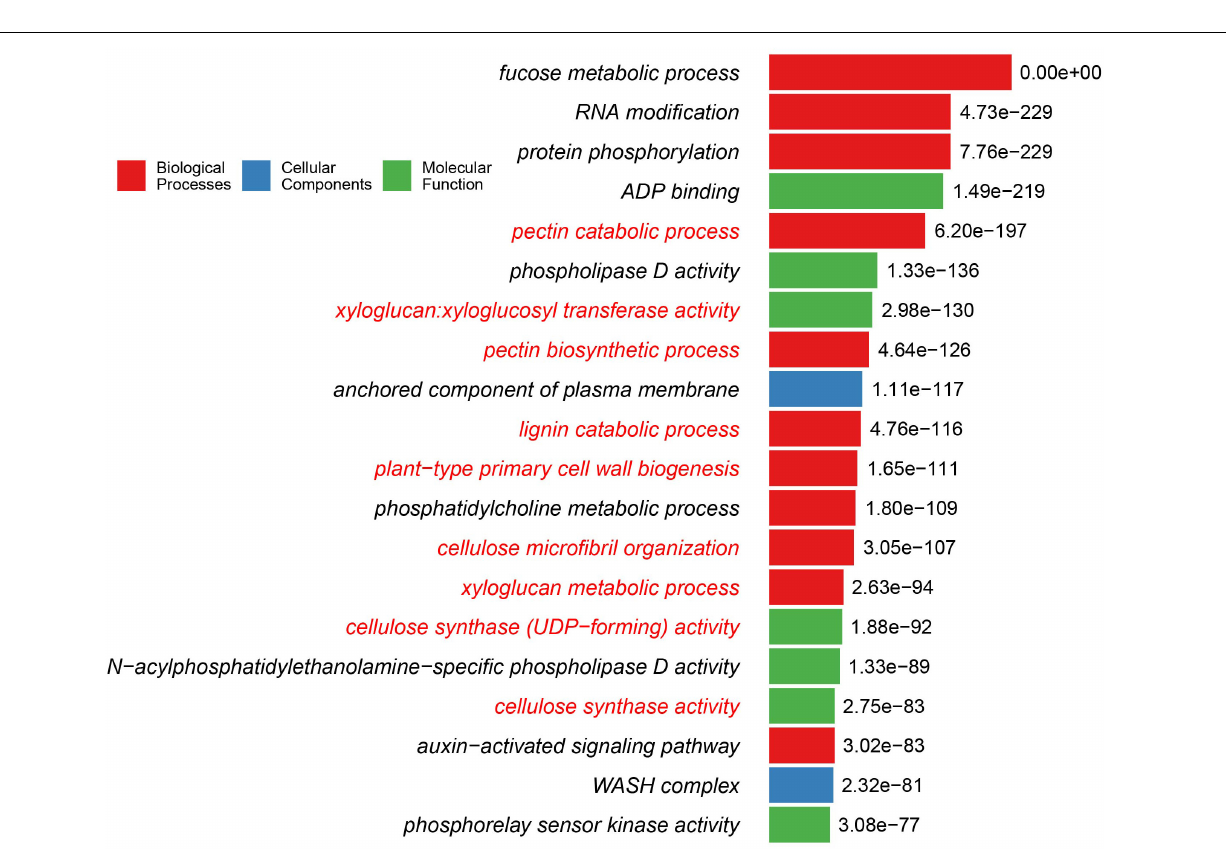
FIGURE 2 | Top 20 GO functions/terms that are over-represented in the Cha+Emb group of OGCs. The y-axis shows the GO terms, and the binomial test adjusted P -values in -log10 form are shown beside the bars. The bars are color-coded according to which of the three top GO levels the term is from. The GO terms are highlighted in red fonts if they are cell wall-related functions. The detailed methods for this GO enrichment analysis is described in Methods. Detailed data used for this plot is available in Supplementary Data Sheet S1